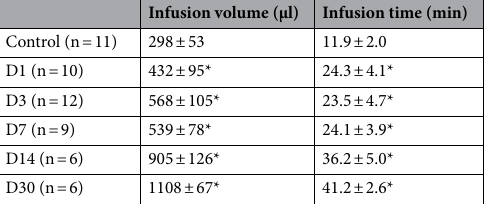
Table 2. Summarized data of infusion volume and time to reach 30cmH 2 0. *P < 0.05 denotes comparison between control and each period after